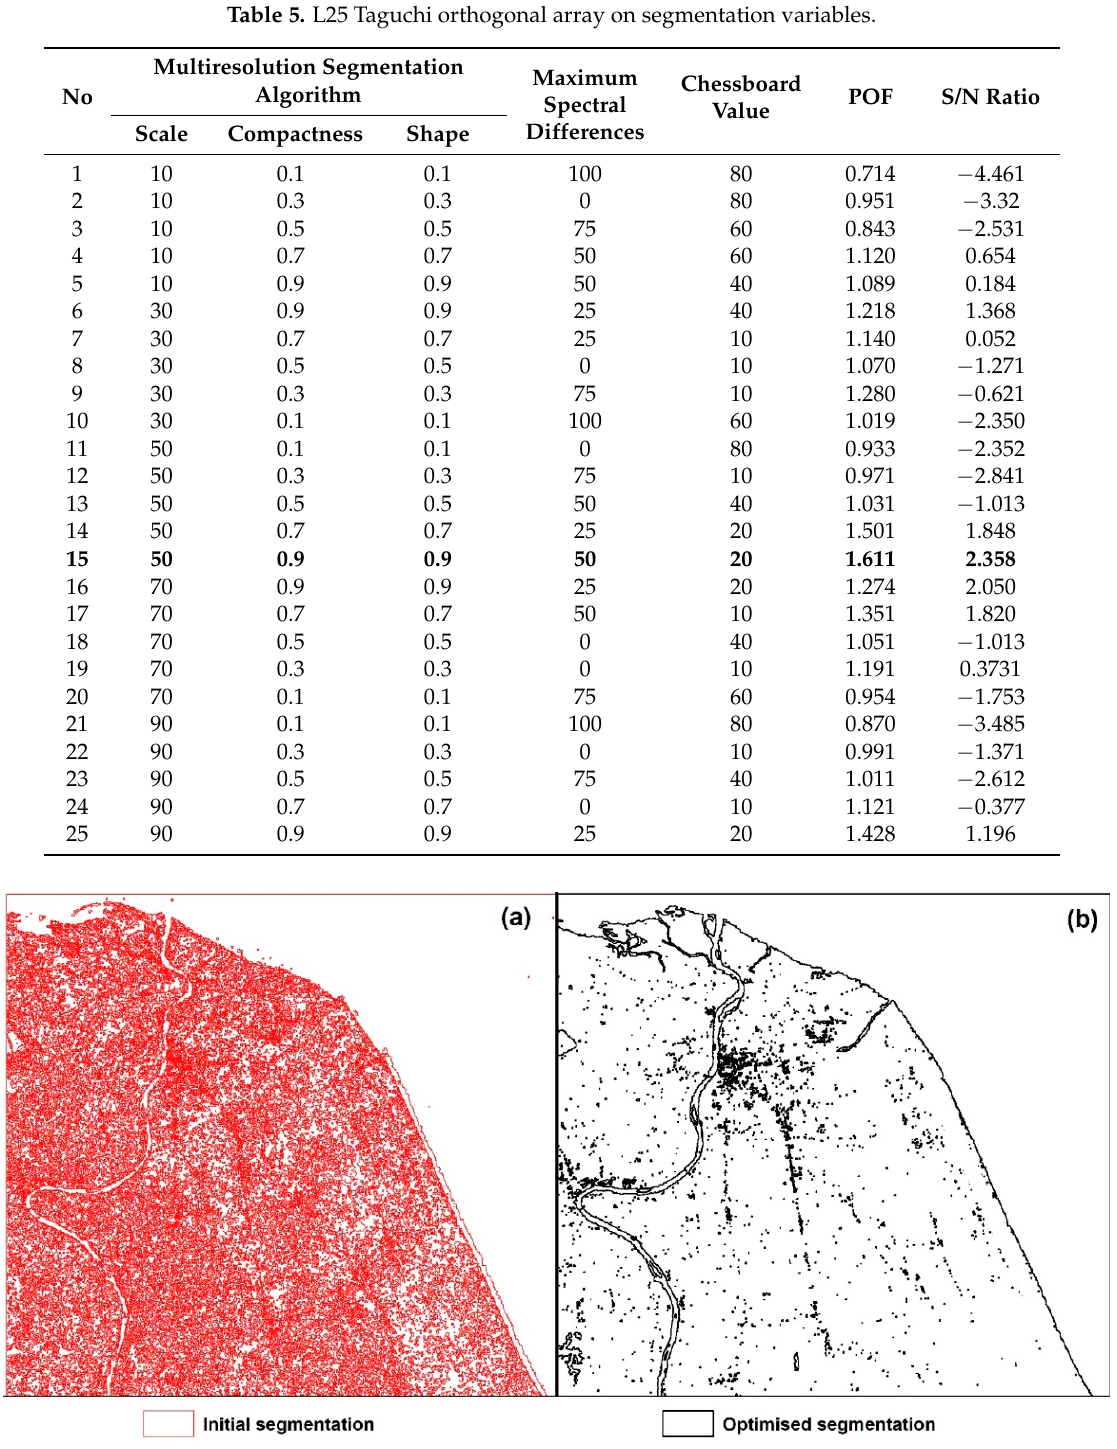
Figure 8. Segmentation results. ( a ) initial segmentation; and ( b ) optimized segmentation.